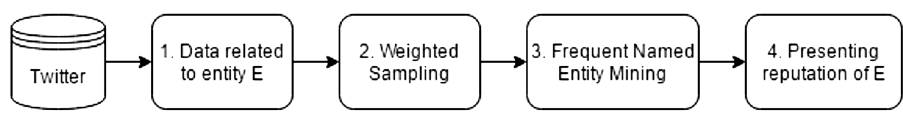
Fig. 1 Overall view of the